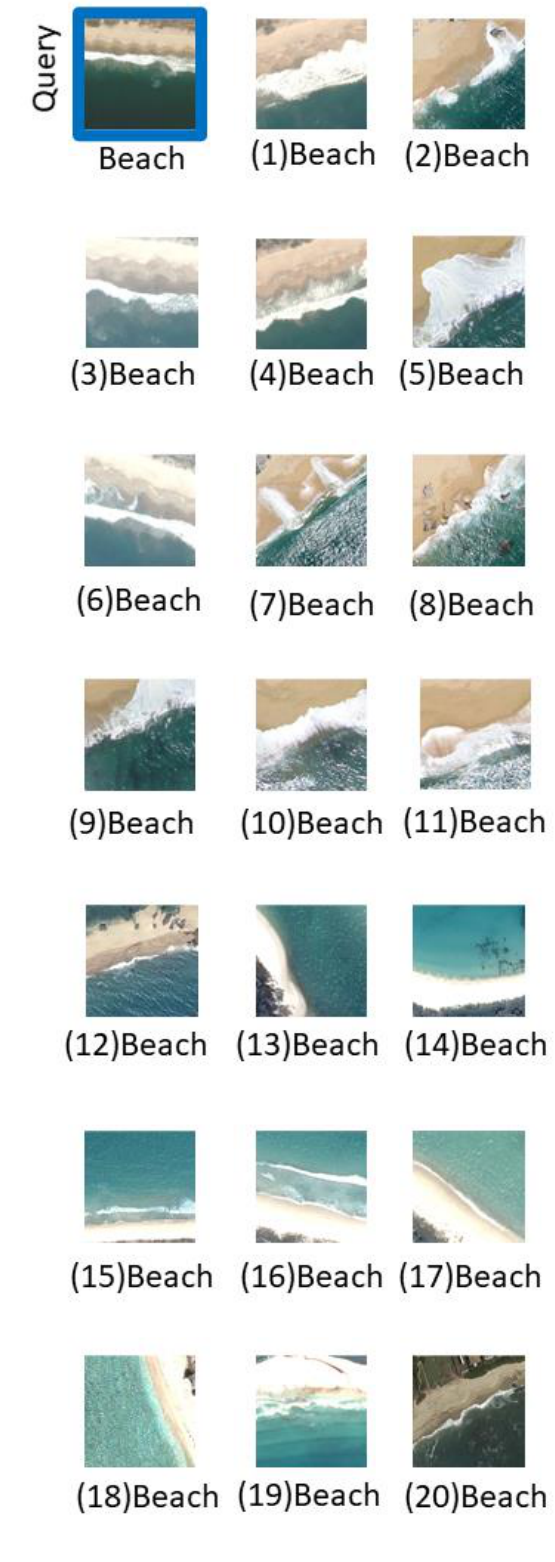
Figure 6. The top 20 retrieval results of our DHCL method on AID. The dotted line separates the retrieval results of different classes. The blue box is used to frame the query image. The words indicate the ground truth of the images above it.